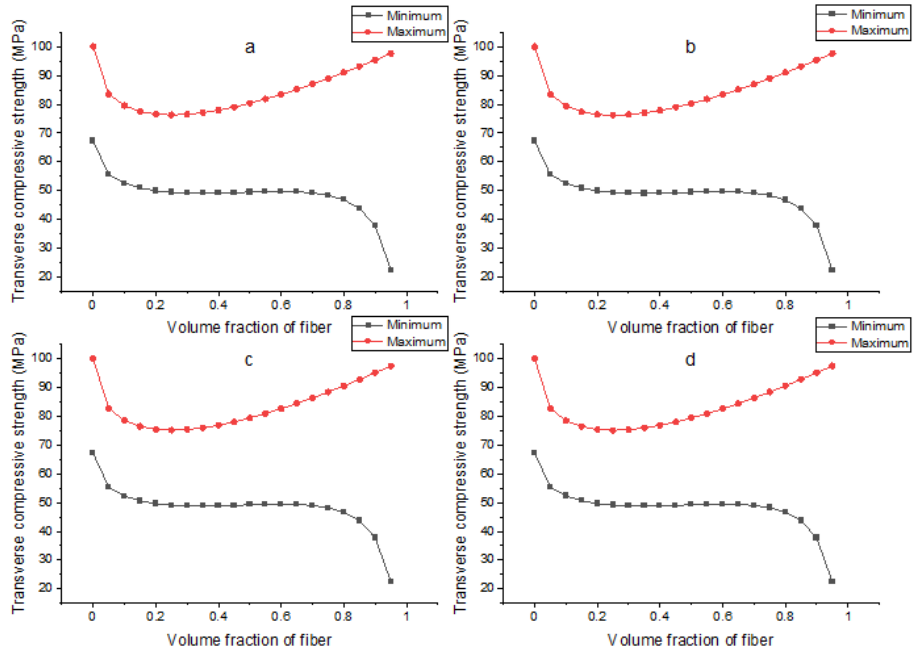
Figure A8. Depicts the variation in transverse compressive strength of ( a ) E-glass, ( b ) S-glass, ( c ) T300 carbon fiber and ( d ) AS carbon with volume of fiber. It can be seen that a wide range between minimum and maximum transverse compressive strength is obtained with increasing fibre